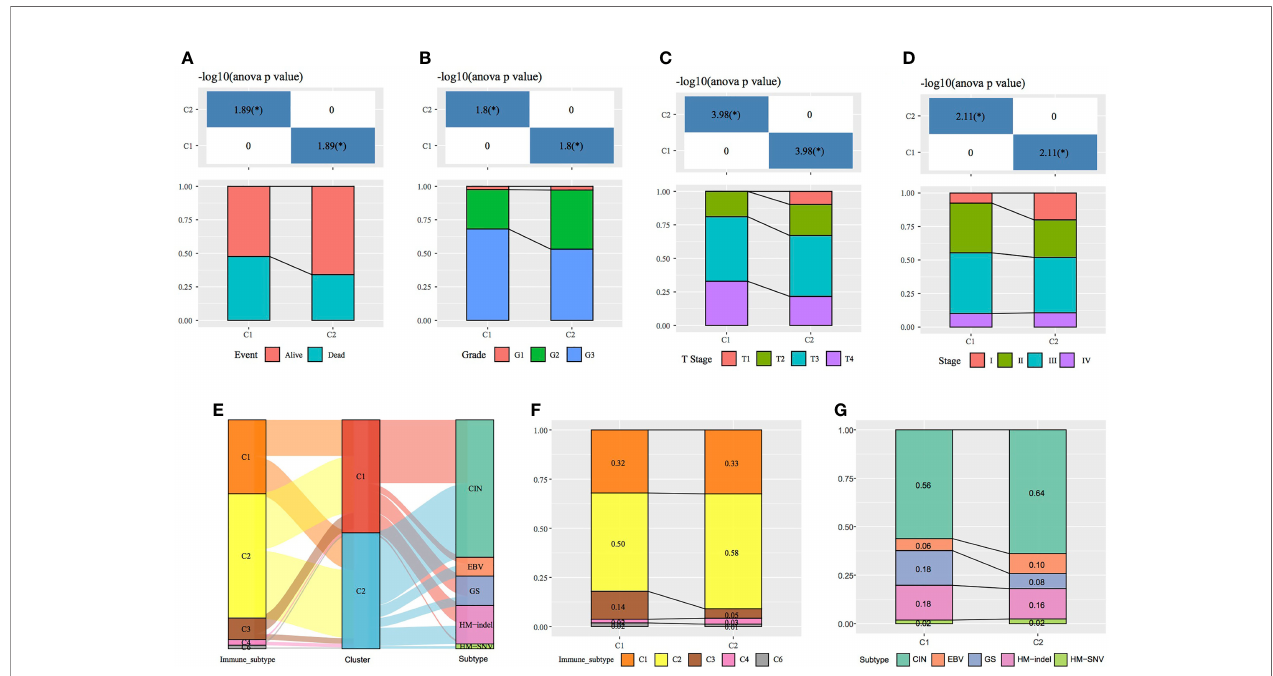
FIGURE 4 | Comparison of clinical features between molecular subtypes. (A – D) Comparison of the distribution of different clinical features between the two molecular subtypes in TCGA dataset. (E) Sankey diagram demonstrating the comparison between the molecular subtypes and existing subtypes. (F) Comparison between the